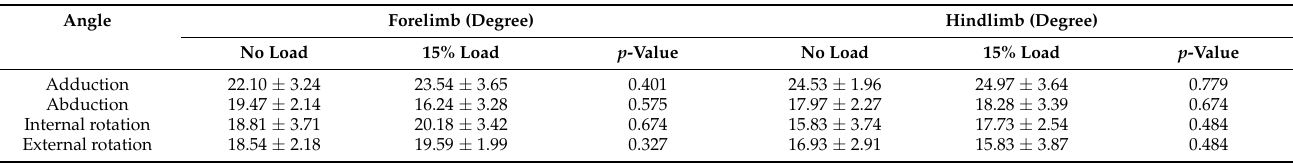
Table 3. Median ( ± SE) proximal angles and rotations in Asian elephants walking with only a mahout on the neck (no load) and with an additional 15% of body mass